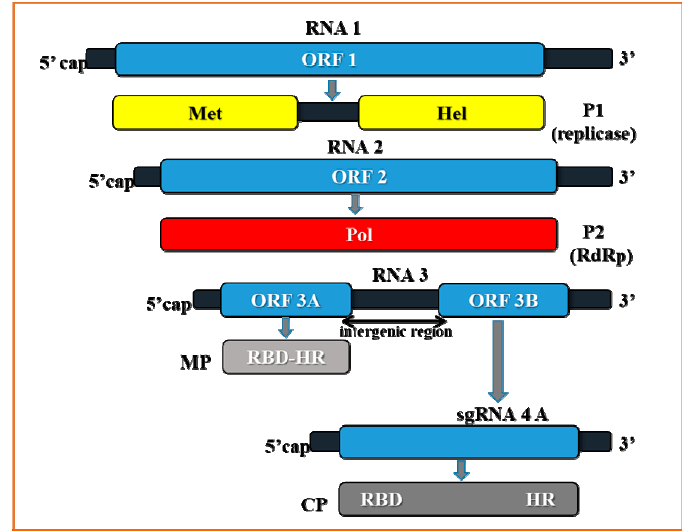
Figure 1. Genome structure of Prune dwarf virus (PDV). Scheme presenting the individual open reading frames (dark blue) and proteins (different colors) encoded by PDV RNAs. Encoded proteins: P1 with methyltransferase and helicase domains (yellow), P2—polymerase (red), MP—movement protein (grey), CP—coat protein (green). ORF—open reading frame, RBD—RNA binding domain, HR—hydrophobic region. Scheme of genome prepared on the basis of the data in Bujarski et al. [1].